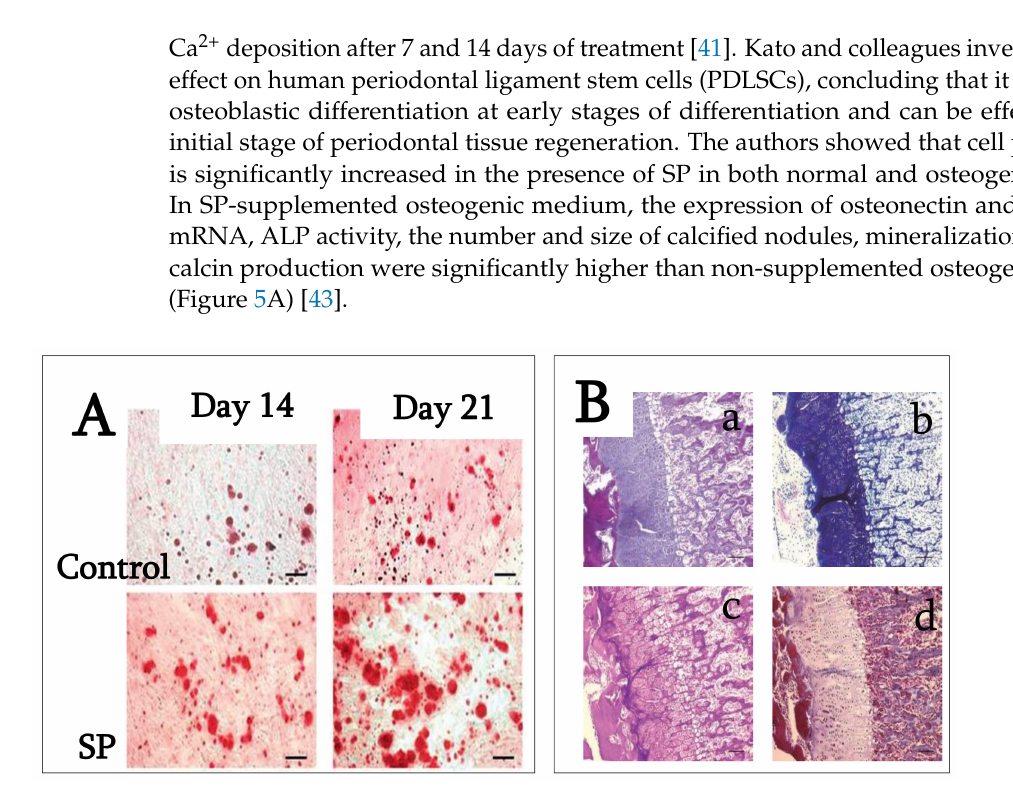
Figure 5. ( A ) PDLSC cultures were stained with alizarin red S after 14 and 21 days of cultivation in osteogenic medium with and without 100 ng/mL SP. Calcium deposition on days 14 and 21 was higher in the presence of SP than in its absence. Bar = 100 mm. (Reproduced with permission from [43]). ( B ) Endochondral ossification and bone formation are observed in the backs of rats 14 days after injection in rats injected with 15 mg/mL concentration of synthetic peptide ( a ): hematoxylin and eosin stain). Metachromasia is demonstrated at cartilage tissue with toluidine blue ( b ). Both cartilage and bone tissue are positive for PAS ( c ), but negative for Masson trichrome ( d ). ( a – d , original mag. × 5; bar: 0.1 mm; reproduced from